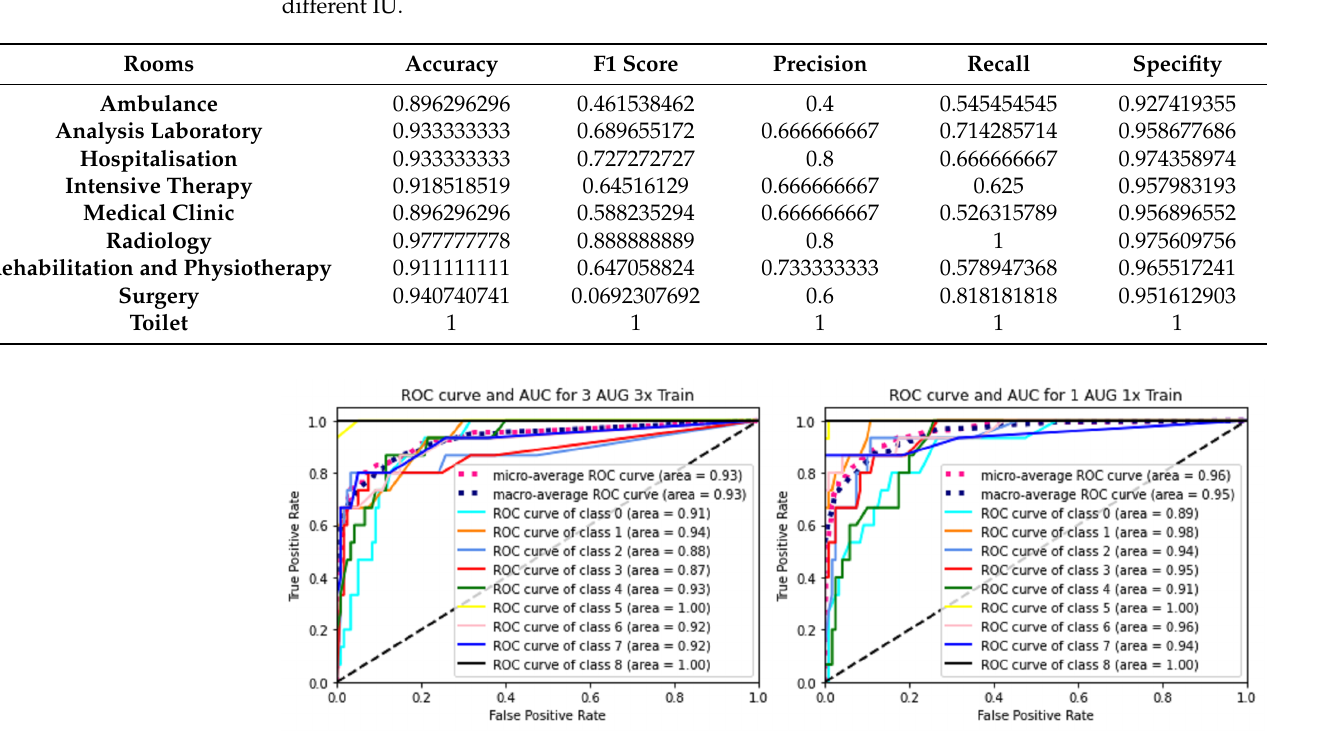
Figure 2. ROC and ROC AUC curves obtained for the second model (first version on the left; second version on the